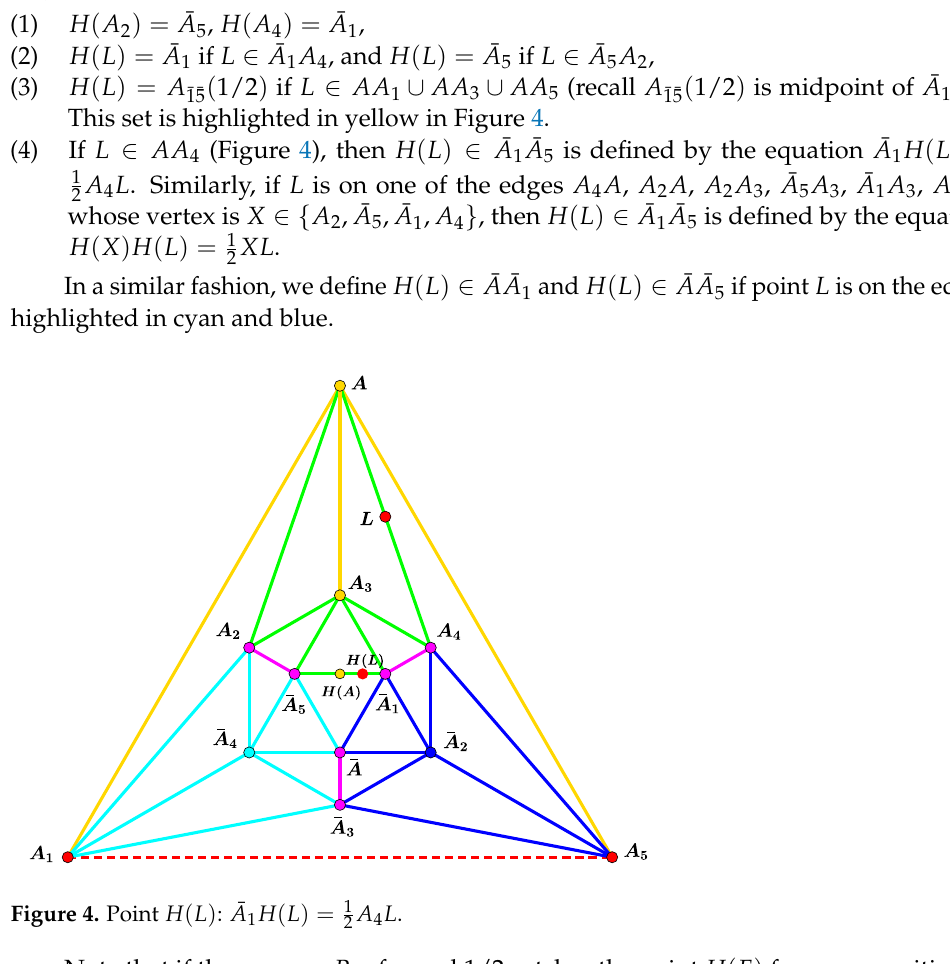
Figure 4. Point H ( L ) : ¯ A 1 H ( L ) = 1